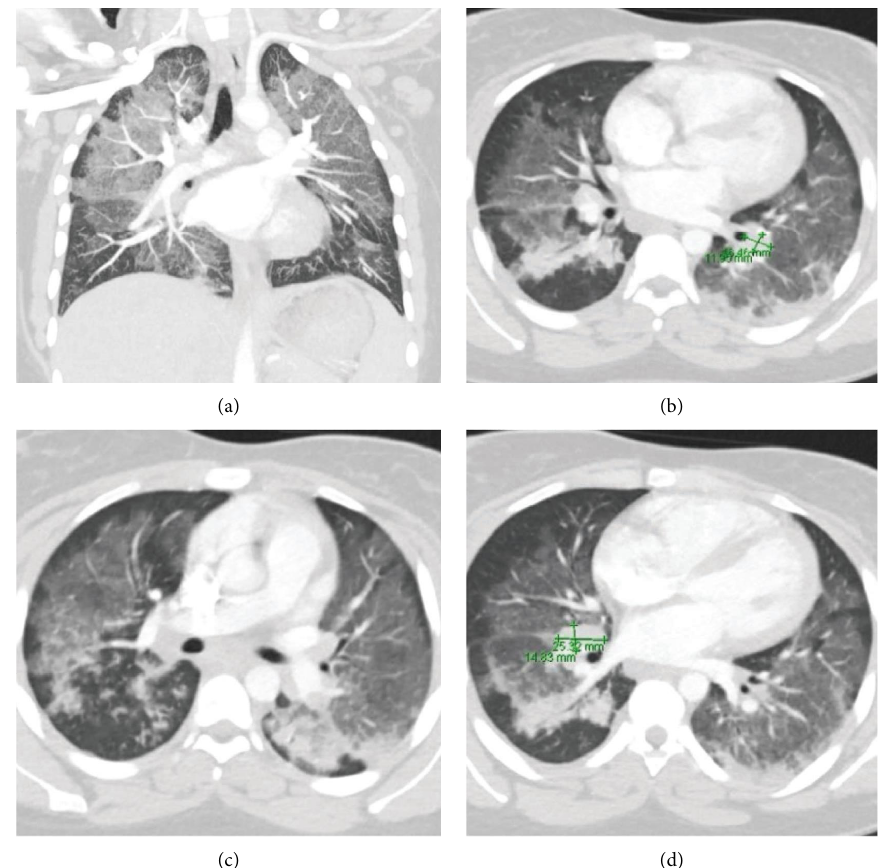
Figure 2: Computed topography (CT) scan showing difuse ground glass opacities (a–d). CT scan also shows mediastinal lymph node enlargement (b, d).